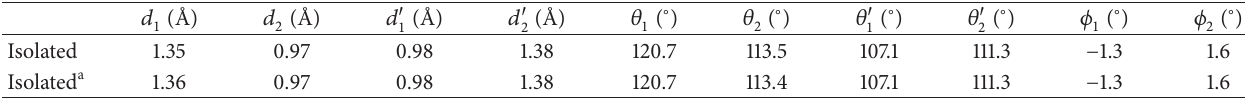
Table 1: Structural parameters of optimized catechol.